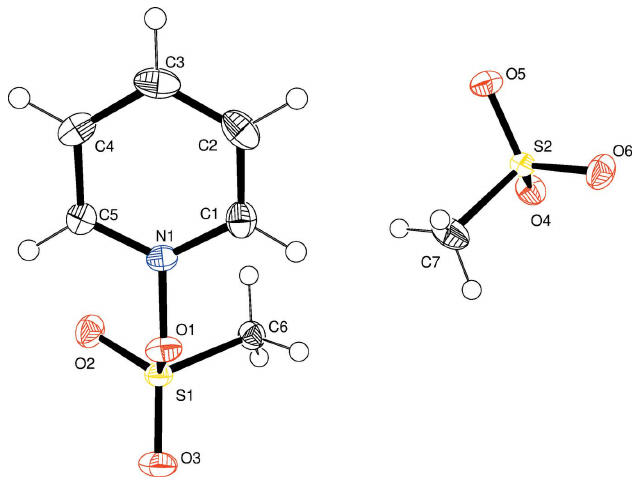
Figure 1 Molecular structure of the title compound with displacement ellipsoids drawn at the 50% probability